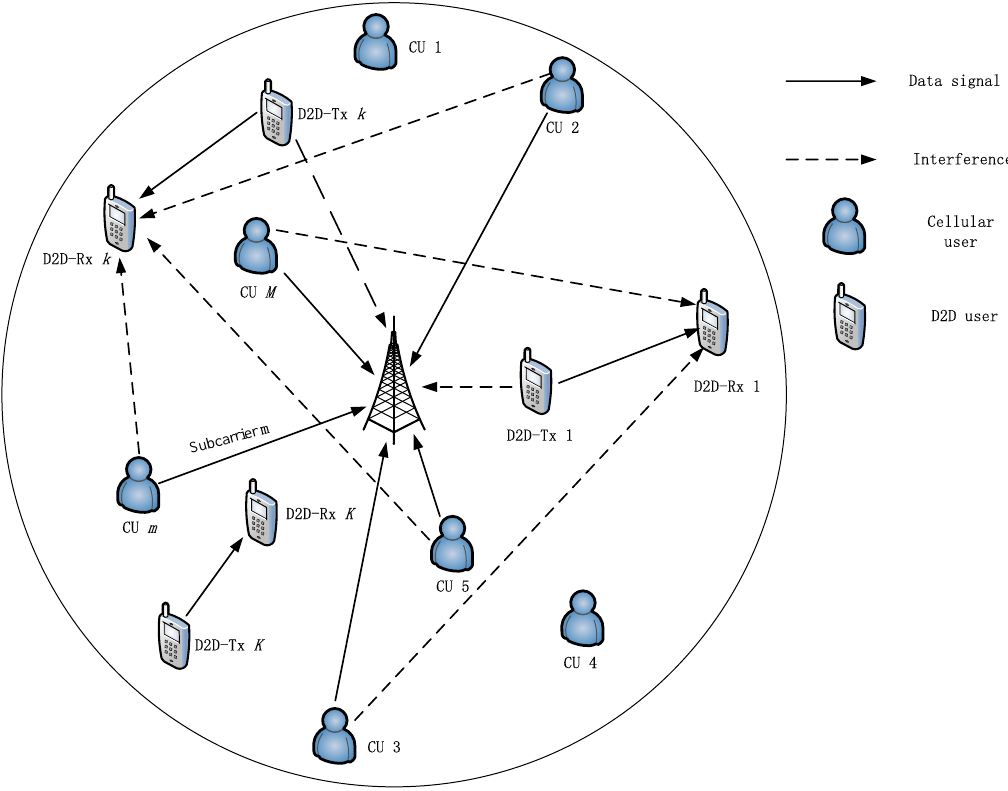
Figure 1. System model of D2D multicast groups and CUs.